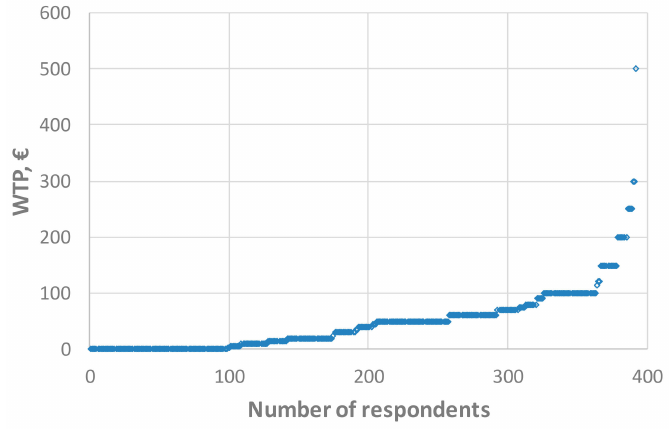
Figure 6. Distribution of the WTP among the respondents (protests are excluded).